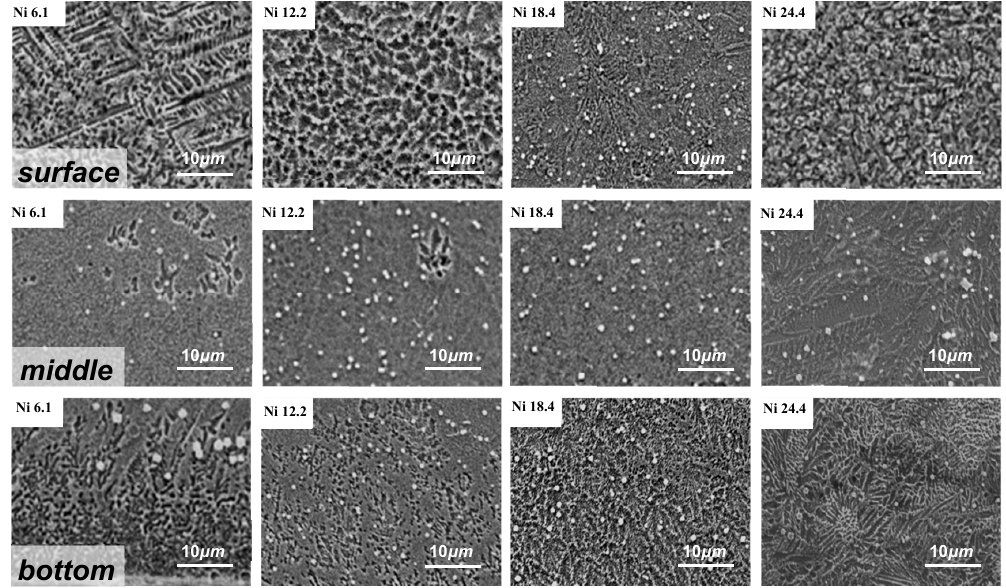
Figure 3. SEM images of the coating cross ‐ section for 6.1% Ni, 12.2% Ni, 18.4% Ni, and 24.4% Ni.